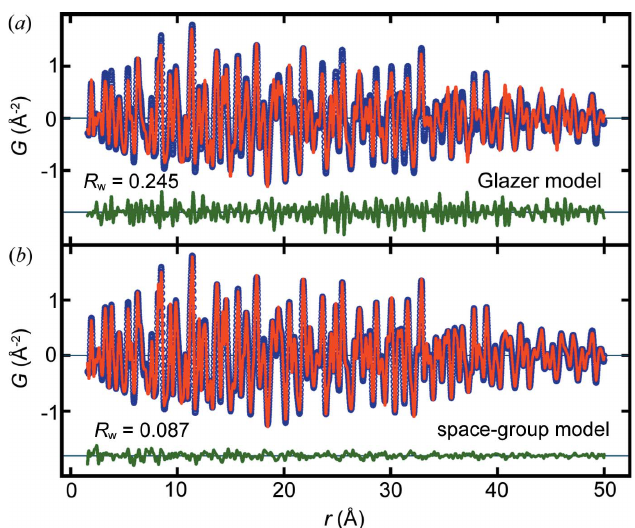
Figure 3 Plots of measured (blue) and best-fit (red) PDFs of CaTiO 3 with the difference curve plotted in green offset below over the r range 1.6–50 A˚ . The model for the best-fit PDF is from ( a ) the constrained Glazer tilt model in Glazer system 10 and ( b ) allowing all the structural degrees of freedom of the Pnma space-group